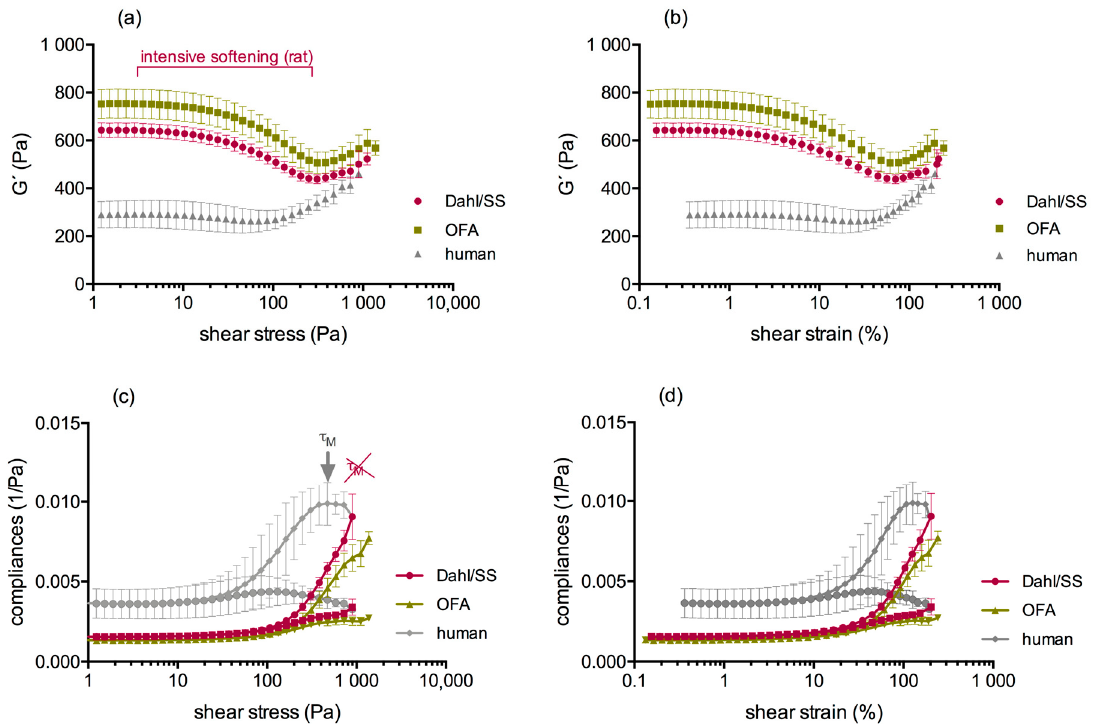
Figure 6. LAOStress tests of whole blood clots from rat strains (purple: Dahl/SS, green: OFA) compared to human (grey). Rat clots showed a phase of intensive softening before they started to shear stiffen ( a , b ). However, G’ did not reach initial values again. In contrast, human clots started to shear-stiffen at lower shear stress, and G ´ raised progressively. In contrast to human clots, rat clots could not align all fibers in the direction of the shear ( c , d ) τ M is lacking in